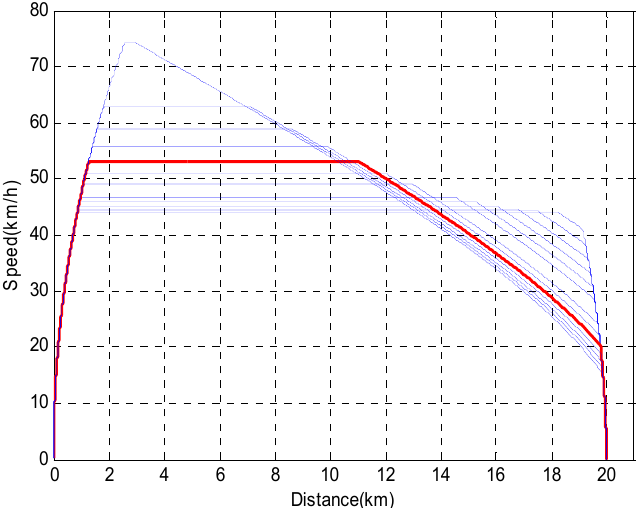
V and switching points. h